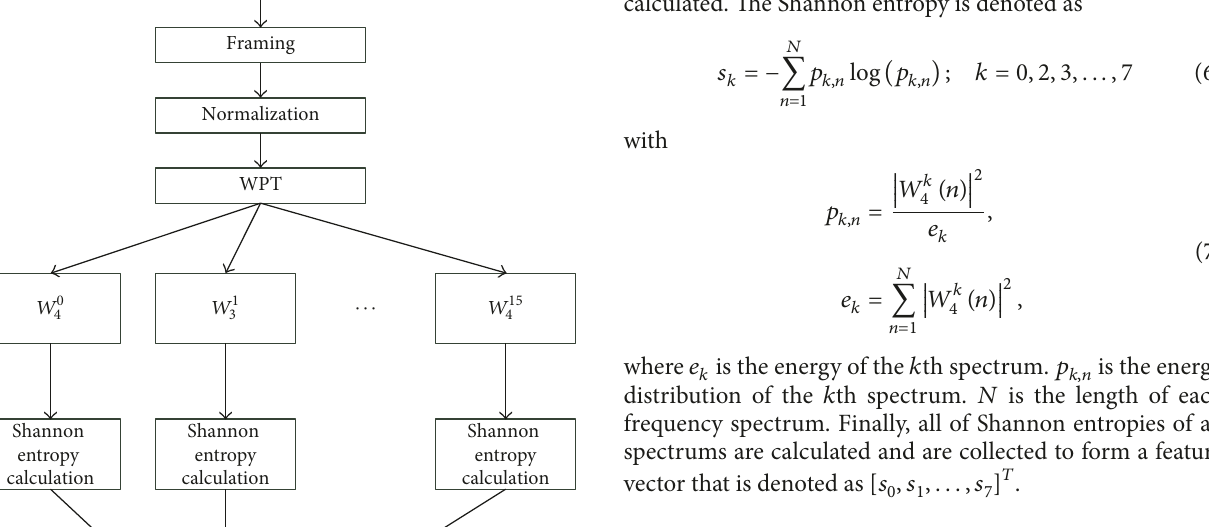
processes followed by 2 : 1 downsampling, respectively. The filtering processes are defined